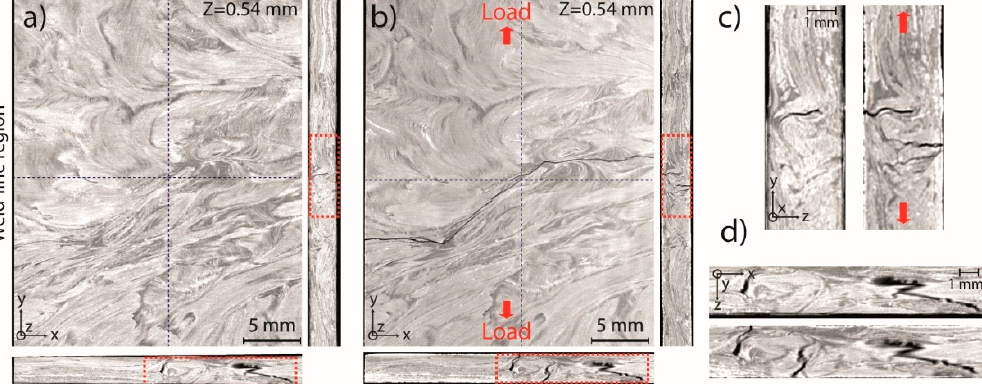
Figure 10. Flow tensile coupon micro-CT, in plane (upper) out-of-plane (lower), ( a ) before testing; ( b ) after testing; ( c , d ) larger sections of both scans for ( c ) in-plane and ( d ) out-of-plane, also before and after failure.